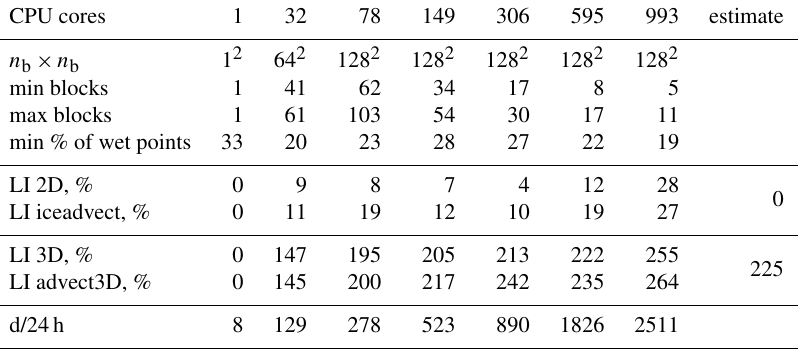
Table 2. Same as Table 1, but for the hilbert2d partition; min and max operations are applied over CPU cores. The column “estimate” shows the theoretical LI values given in Appendix A.